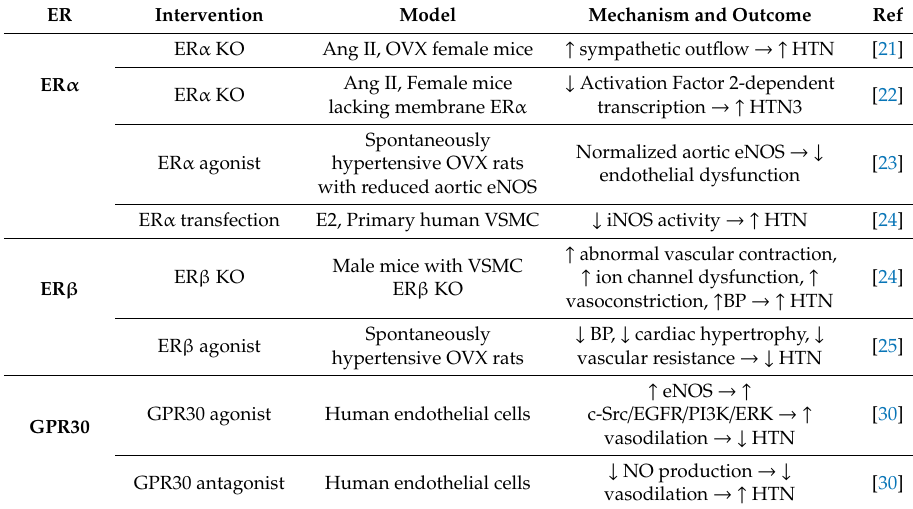
Table 1. Role of estrogen receptors in